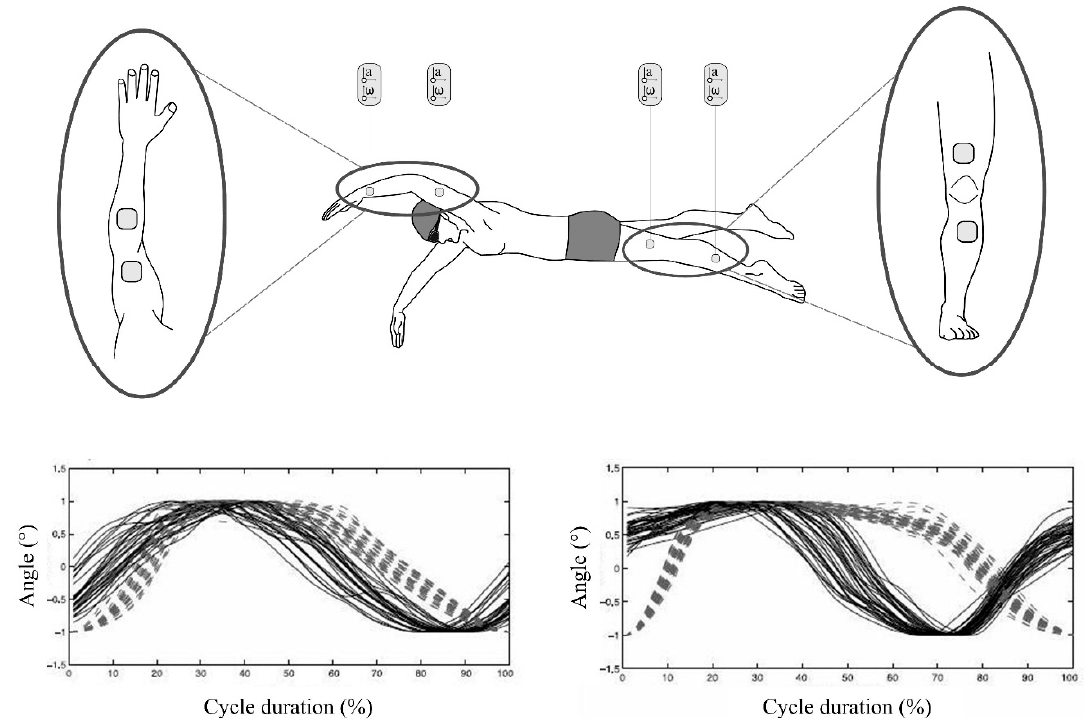
Figure 23. Comparison of changing joint angles produced during breaststroke stroke cycles measured using a multi-sensor system. The ideal pattern at the start of each cycle is for the knee joint (dashed line) to be at maximum flexion when the elbow joint (solid line) is near maximum extension. This is demonstrated on the right hand graph with data from an elite performer. The graph of the left hand side would be characteristic of a beginner who demonstrates near simultaneous knee and elbow movement patterns. In this example, joint angles have been normalised between − 1 (maximum flexion) and +1 (maximum extension). Reproduced with permissions from Seifert, L’Hermette, Komar, Orth, Mell, Merriaux, Grenet, Caritu, Hérault, Dovgalecs and Davids [95].